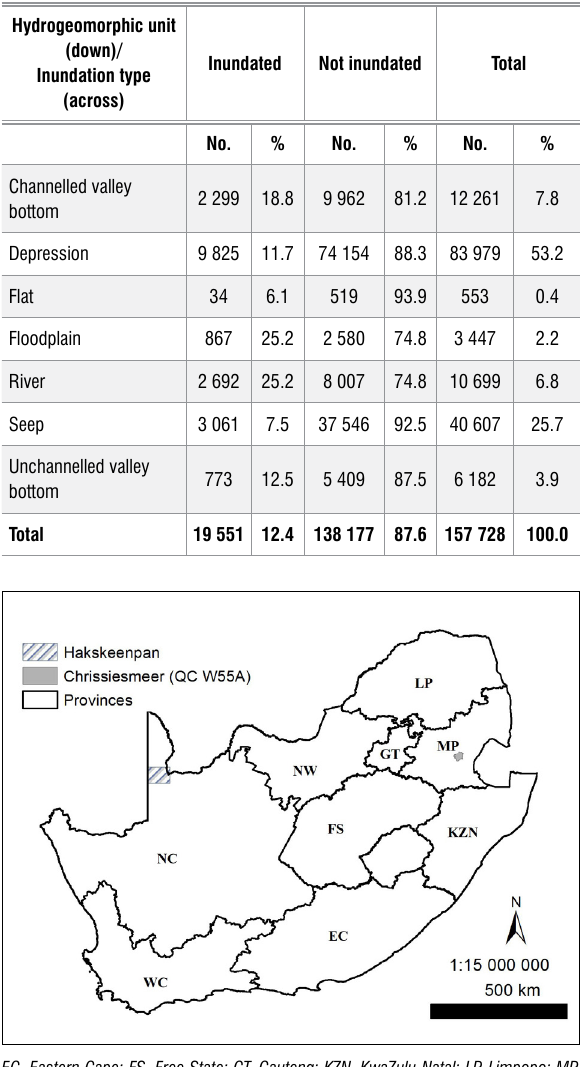
Table 4: Number of polygons and percentage per type inundated, as derived from the Global Surface Water transition data layer 2 for inland wetlands and rivers mapped in National Wetland Map version 5 of South Africa 3